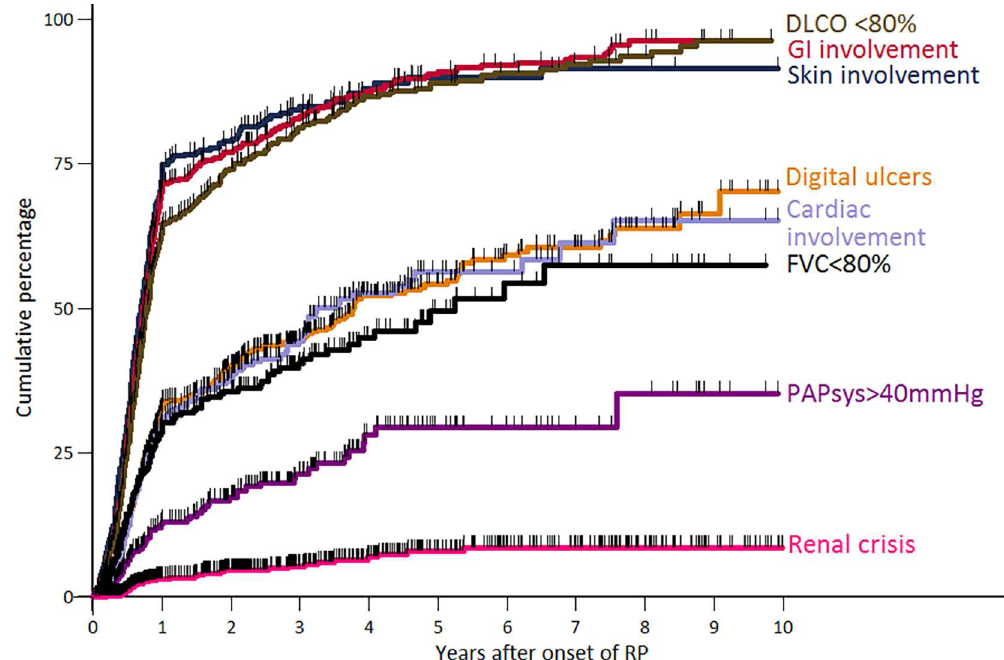
Fig 3. Kaplan-Meier curves of incident organ involvement in SSc patients of the study population after RP onset. RP, Raynaud’sphenomenon; Pts, patients; DLCO, single breath diffusing capacity for monoxide;GI symptoms, gastrointestinal symptoms, defined as a history of either dysphagia,reflux, early satiety, vomiting, diarrhoea,bloating or constipation; Skin involvement, defined as a modified Rodnanskin score of (cid:21) 2 at any part of the body; Cardiac involvement, defined as either the presence of diastolicdysfunction, conductionblocks, a left ventricular ejection fraction (LVEF) < 50%, or a pericardial effusion; FVC, forced vital capacity; PAPsys, systolic pulmonary artery pressure as estimated by